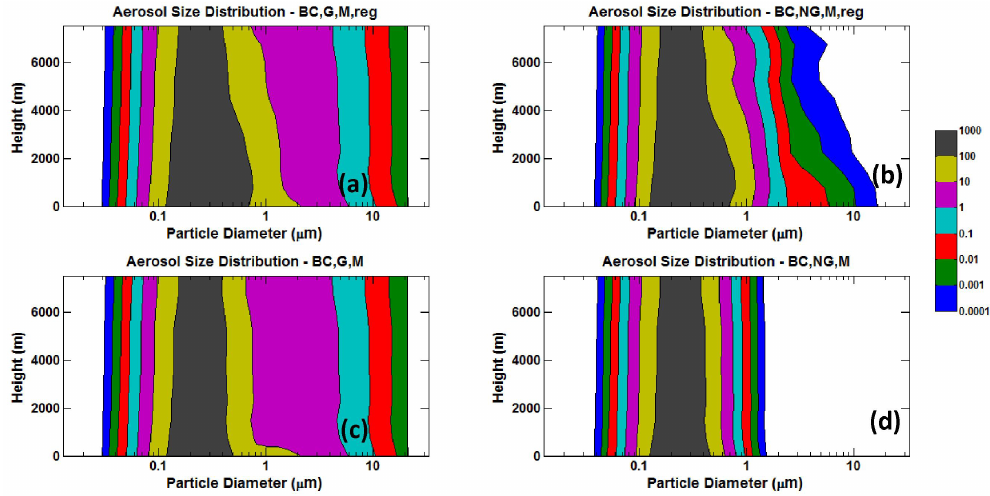
Fig. 11. Sensitivity of the average aerosol size distribution profiles as function of the height to the aerosol regeneration process in the GCCN and no GCCN cases. The calculated data refer to the area which is marked by a red rectangle in Fig. 4.